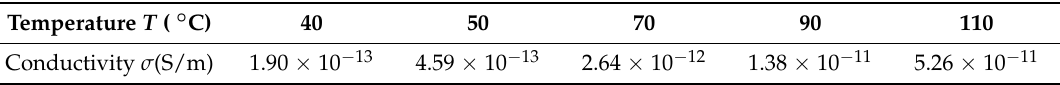
Table 3. Temperature ‐ dependent conductivity of oil ‐ impregnated paper (measured at 1 kV/mm electric field).